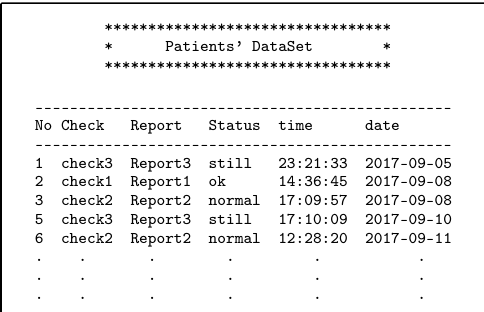
Figure 15. Users’ scenarios in PAX.